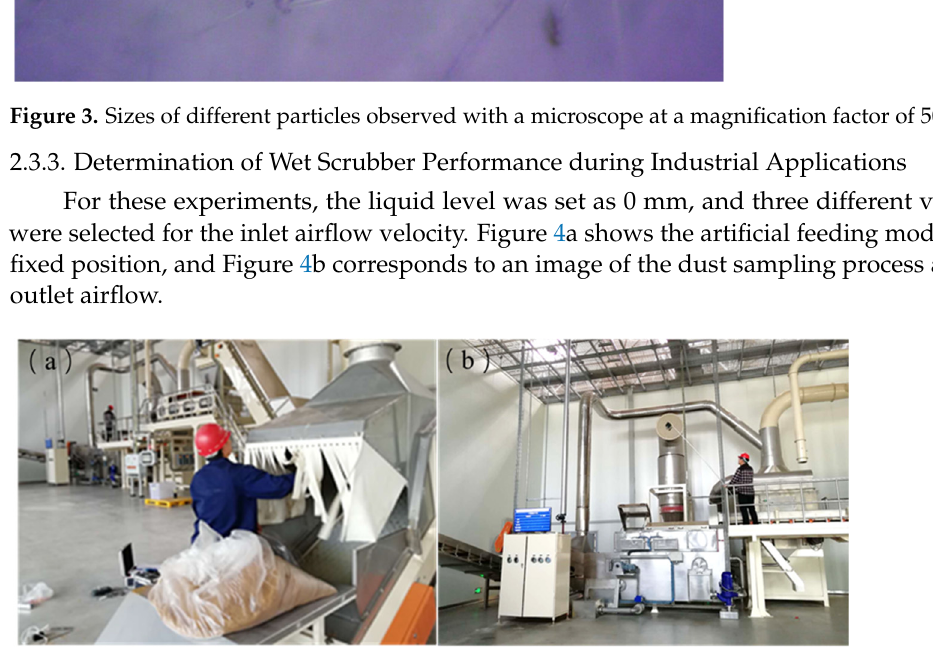
Figure 4. ( a ) Artificial feeding; ( b ) dust sampling at the airflow outlet.